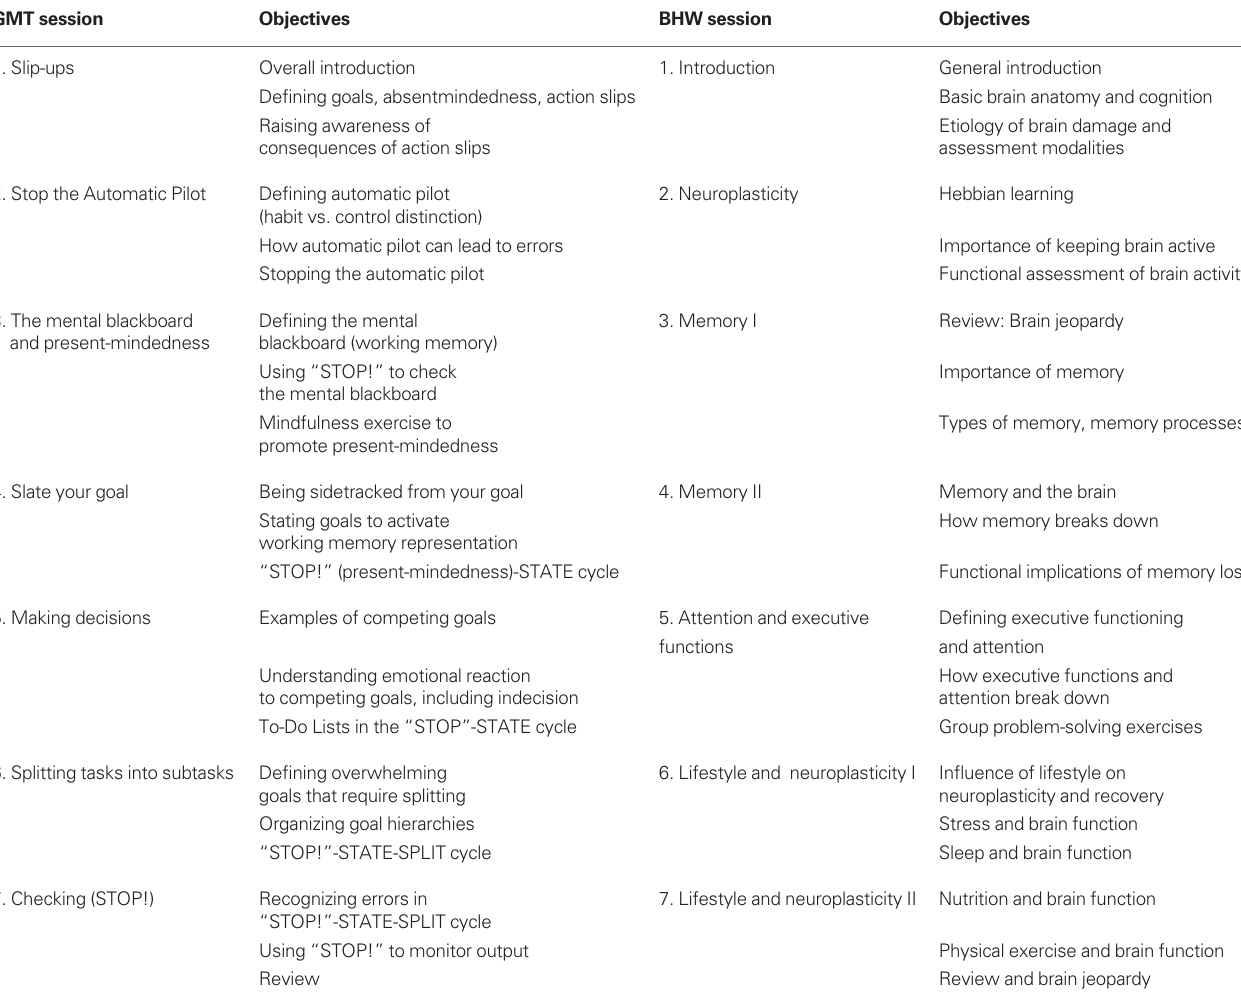
Table 2 | Description of goal management training (GMT) and brain health workshop (BHW)